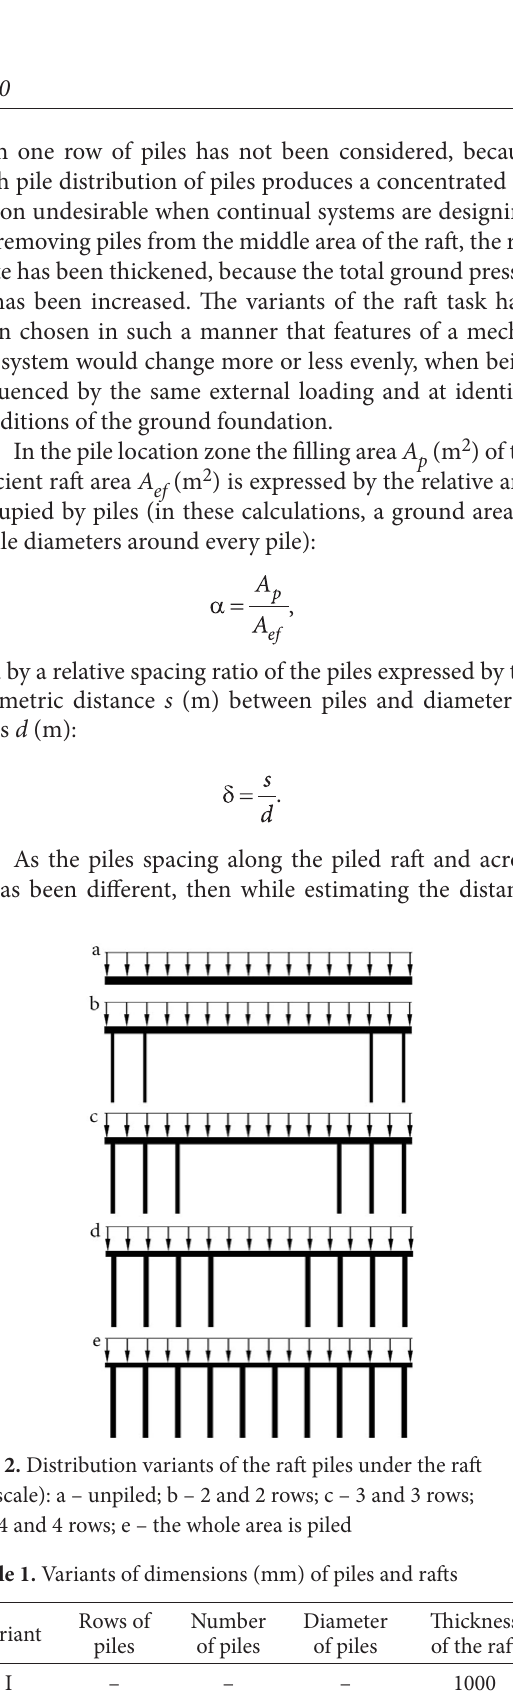
Thickness of the raft